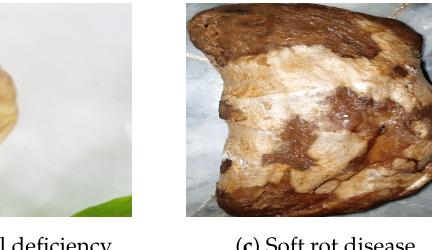
Figure 3. Distribution of the dataset. ( a ) Data distribution for pest patterns. ( b ) Data distribution for nutritional deficiency. ( c ) Data distribution for soft rot disease.